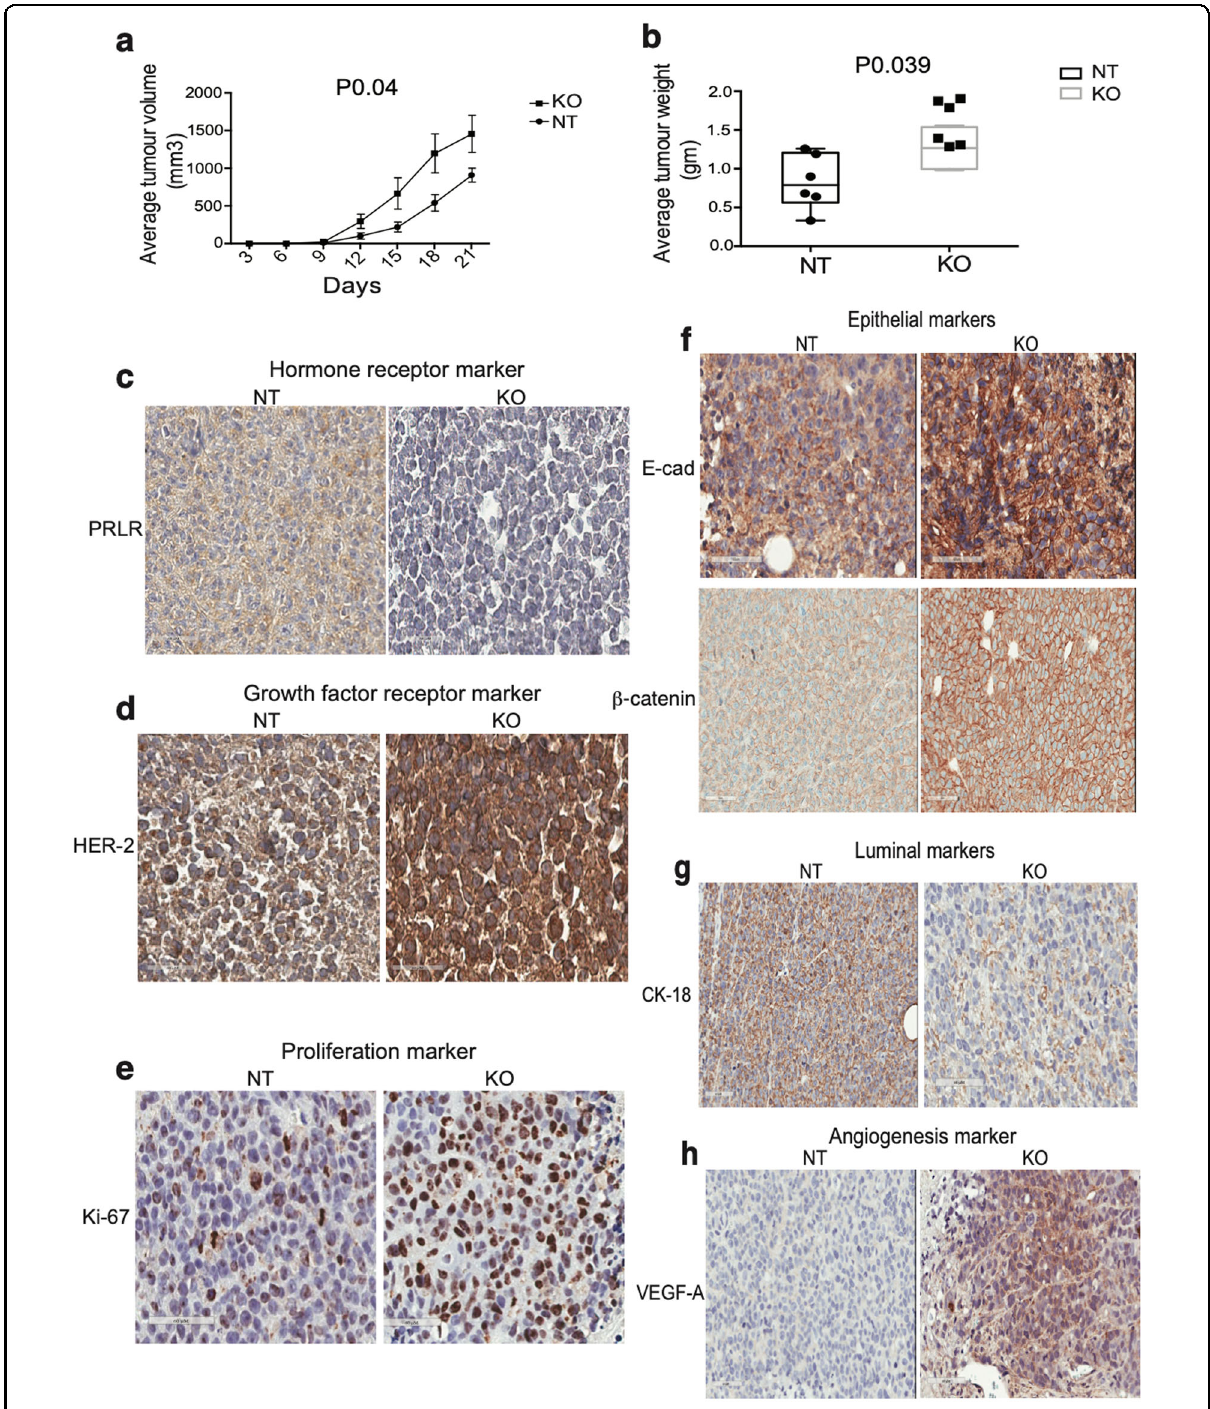
Fig. 6 Loss of PRLR expression in SKBR-3 breast cancer cells accelerated tumor development showing epithelial, proliferative, and highly vascular phenotype with augmented HER-2 expression in vivo. a Measurements of tumor volume of xenografts of SKBR-3/NT and SKBR-3/ PRLRKO followed for a period of 21 days, * P 0.04 (Student ’ s t -test). b Measurements of tumor weight of xenografts of SKBR-3/NT and SKBR-3/PRLRKO, * P 0.039 (Student ’ s t -test). c Immunohistochemical staining of PRLR in SKBR-3/NT and SKBR-3/PRLRKO tumor (×40). d Immunohistochemical staining of HER-2 in SKBR-3/NT and SKBR-3/PRLRKO tumor (×40). e Immunohistochemical staining of the proliferative marker Ki67 in SKBR-3/NT and SKBR-3/ PRLRKO tumor (×40). f Immunohistochemical staining of the epithelial markers, E-cad and β -catenin, in SKBR-3/NT and SKBR-3/PRLRKO tumor (×40). g Immunohistochemical staining of the luminal marker CK18 in SKBR-3/NT and SKBR-3/PRLRKO tumor (×40). h immunohistochemical staining of the angiogenesis marker VEGFA in SKBR-3/NT and SKBR-3/PRLRKO tumor (×40).